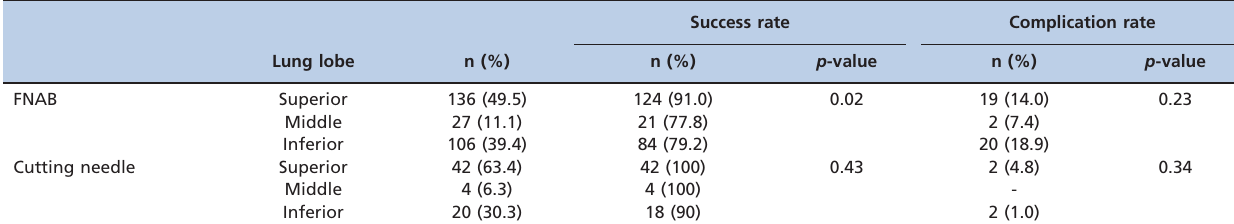
Table 3 - Success and complication rates of FNAB and cutting-needle biopsy according to lung lobe affected.